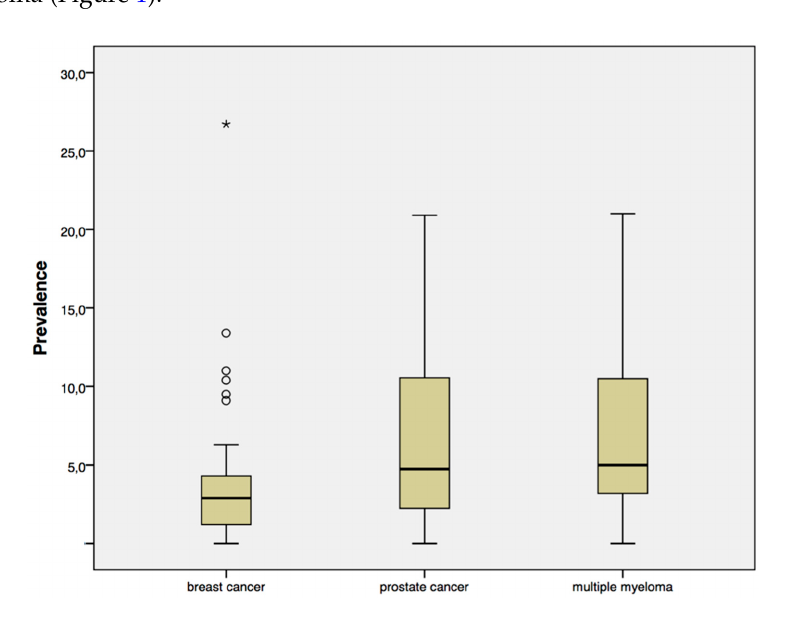
Table 2. Weighted prevalences in breast cancer, prostate cancer, and multiple myeloma patients. Breast Cancer Prostate Cancer